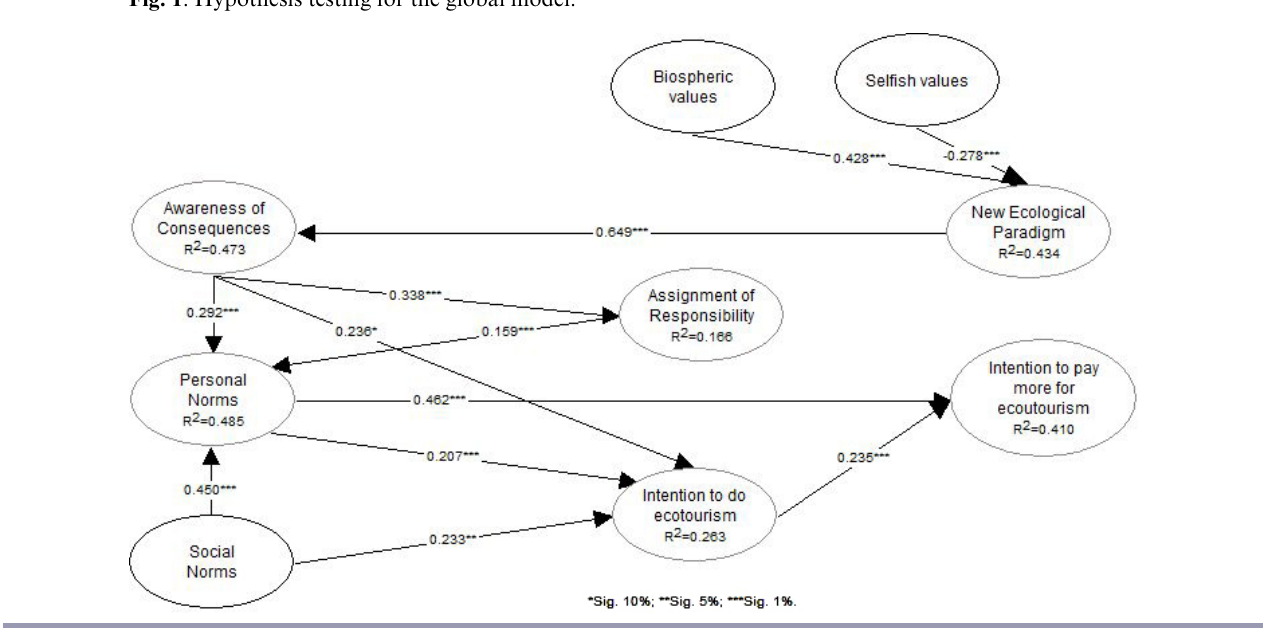
Fig. 1 . Hypothesis testing for the global model.